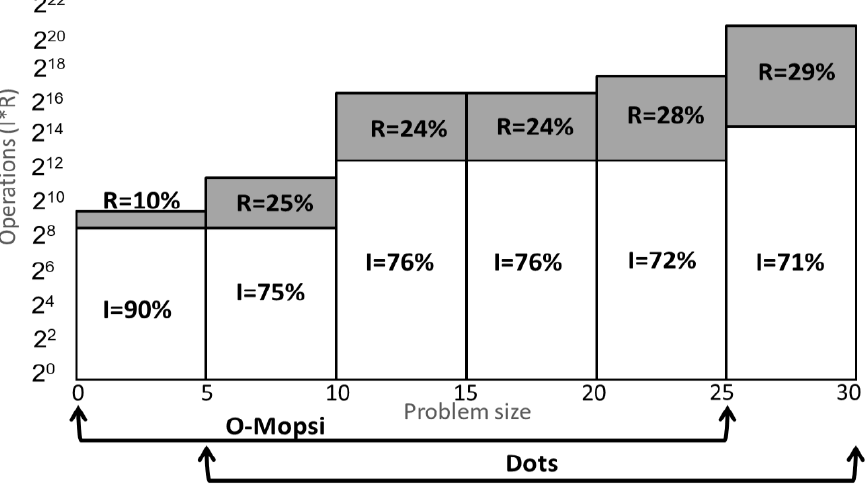
Figure 19. Required number of operations increases with problem size.